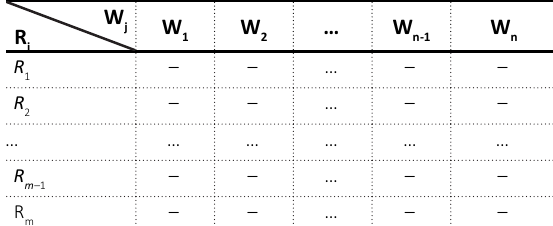
Table 1. Payoff matrix of the game against nature